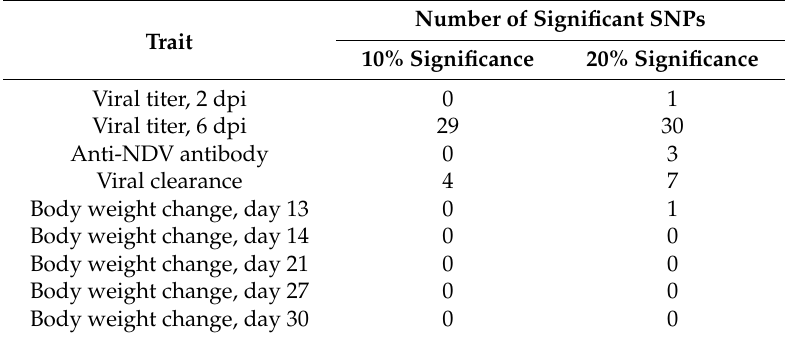
Table 3. Number of significant SNPs identified at the 10 and 20% genome-wide significance levels across all traits.